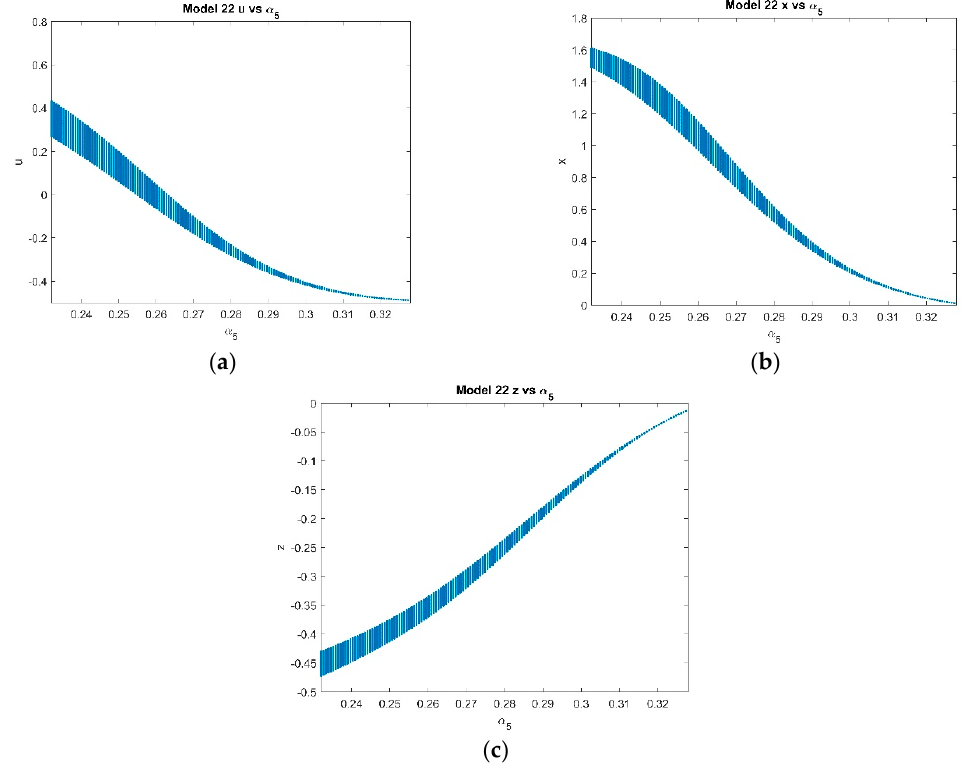
= 0.002. Figure 4. CEFD model (21); bifurcation of ( a ) 𝑢 ( b ) 𝑥 ( c ) 𝑧 versus 𝛼 (cid:2873) for ℎ = 0.002 . 5 for h